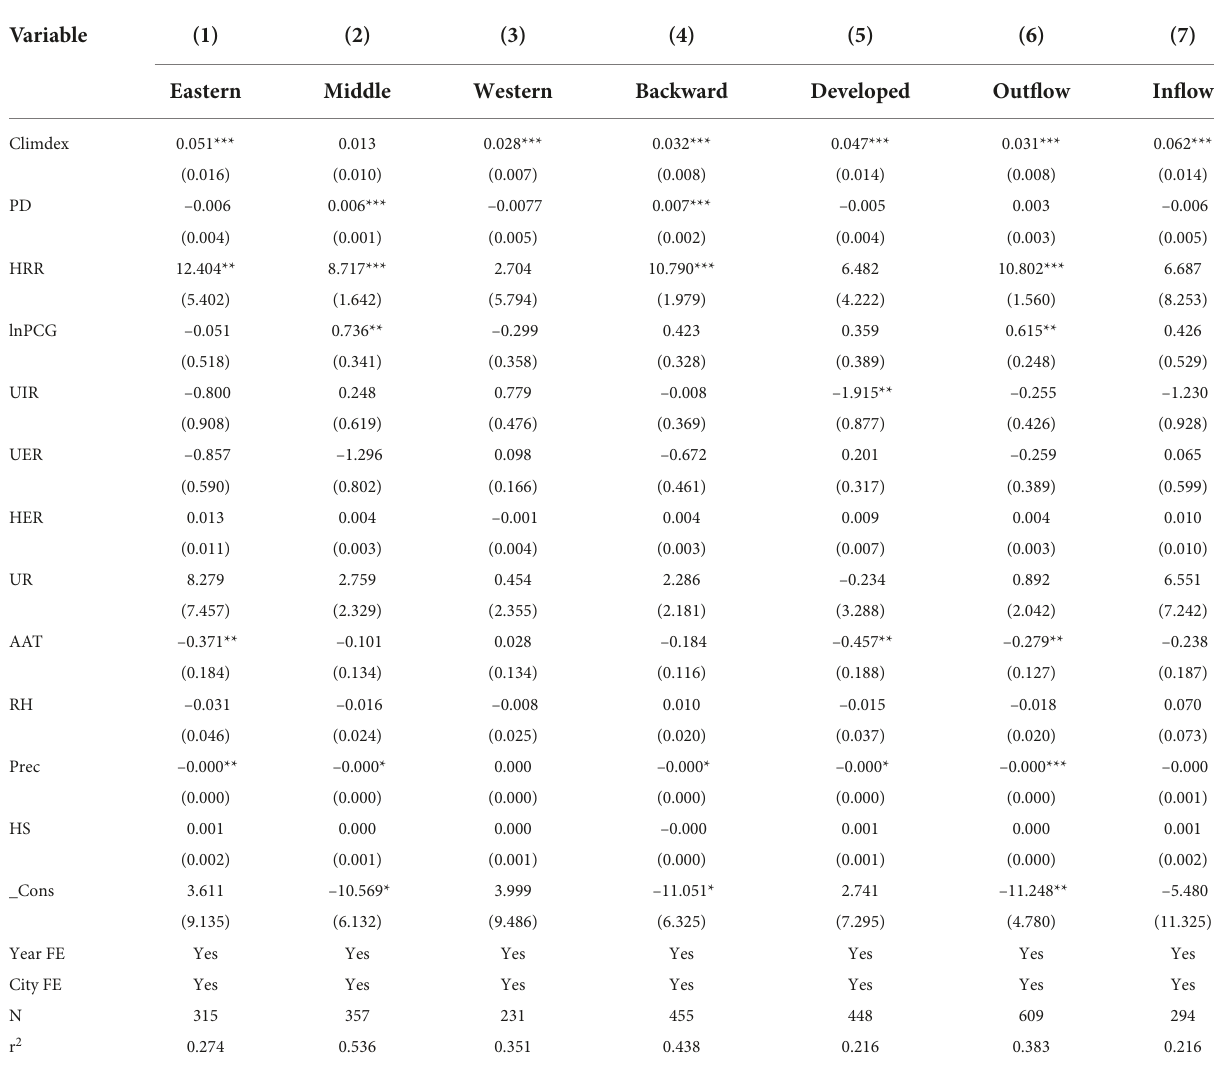
TABLE 7 Heterogeneous effects of climate extremes on crime